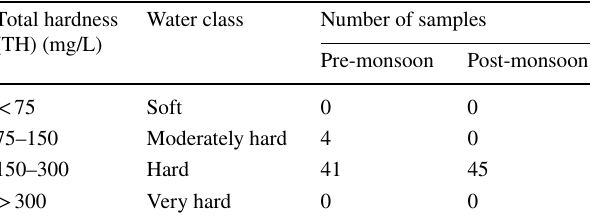
Table 7 Classification of groundwater samples collected from the proximity of Beas River, India Total hardness (TH)